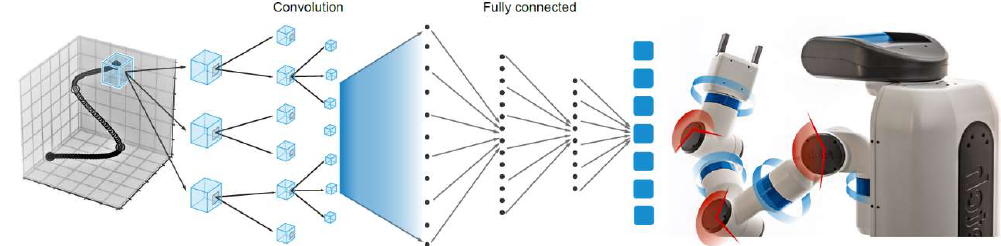
Figure 8. Network architecture for the kinematic control of a robotic manipulator.